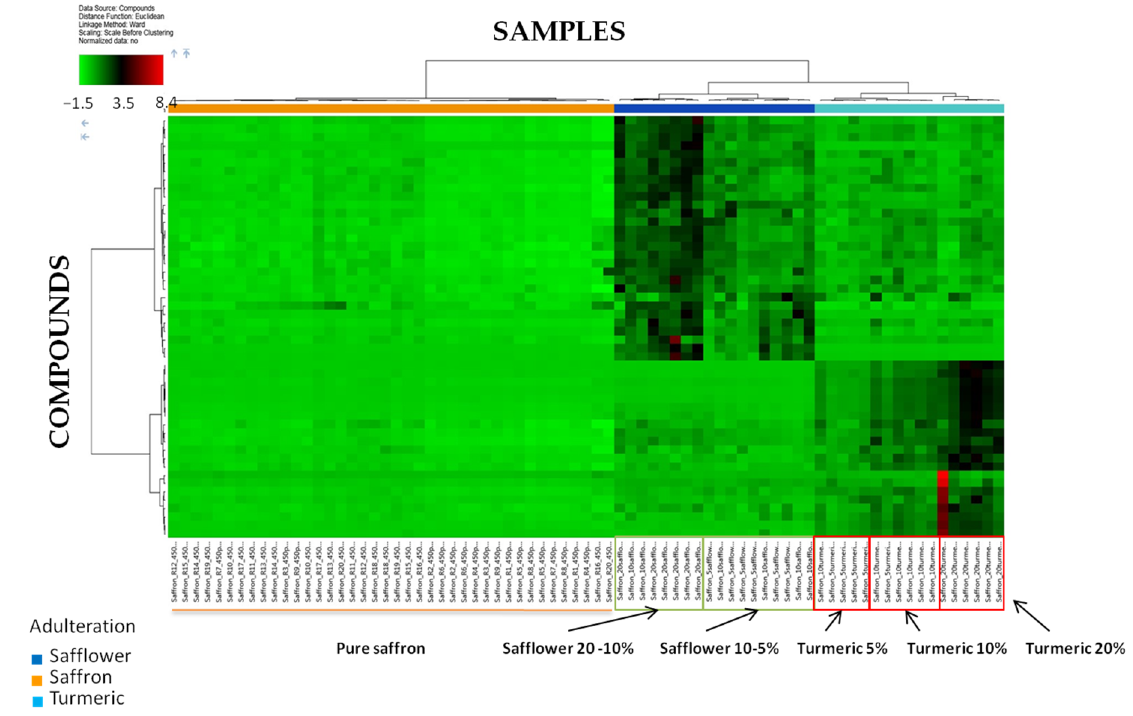
Figure 2. Hierarchical Cluster Analysis of the peak areas recorded for the compounds list obtained after filtration of the software output by p -value ≤0.05 in every ratio of the ANOVA test.